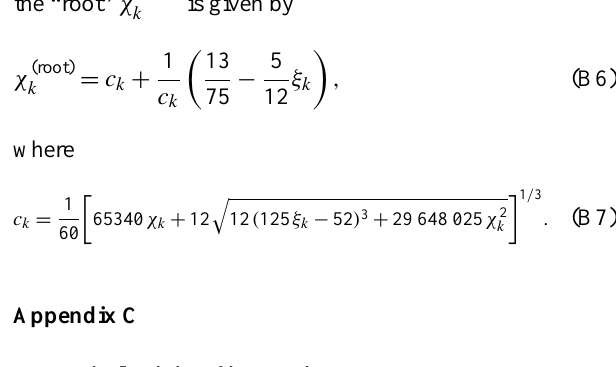
Fig. C1. A schematic of the classification of numerical mixing. If a scatter point is located in the area labeled with A (mathematically defined in (C2)) it is categorized as ‘real’ mixing . Similarly for the area labeled with B (defined in (C4)) it is categorized as range- preserving unmixing . The remaining part of the domain is referred to as overshooting . The thick solid line is the preexisting non-linear functional relation curve. See text or Lauritzen and Thuburn (2011) for details.